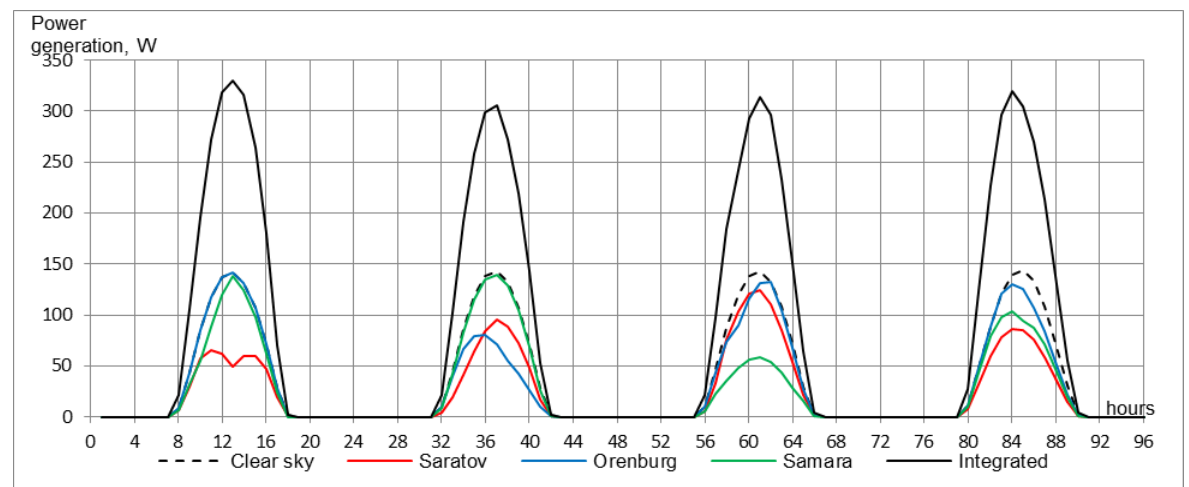
Fig. 5 . Solar panel power generation curves in three areas in February 2018 Power generation curves as a result of joint generation of three SPP have smaller amplitude